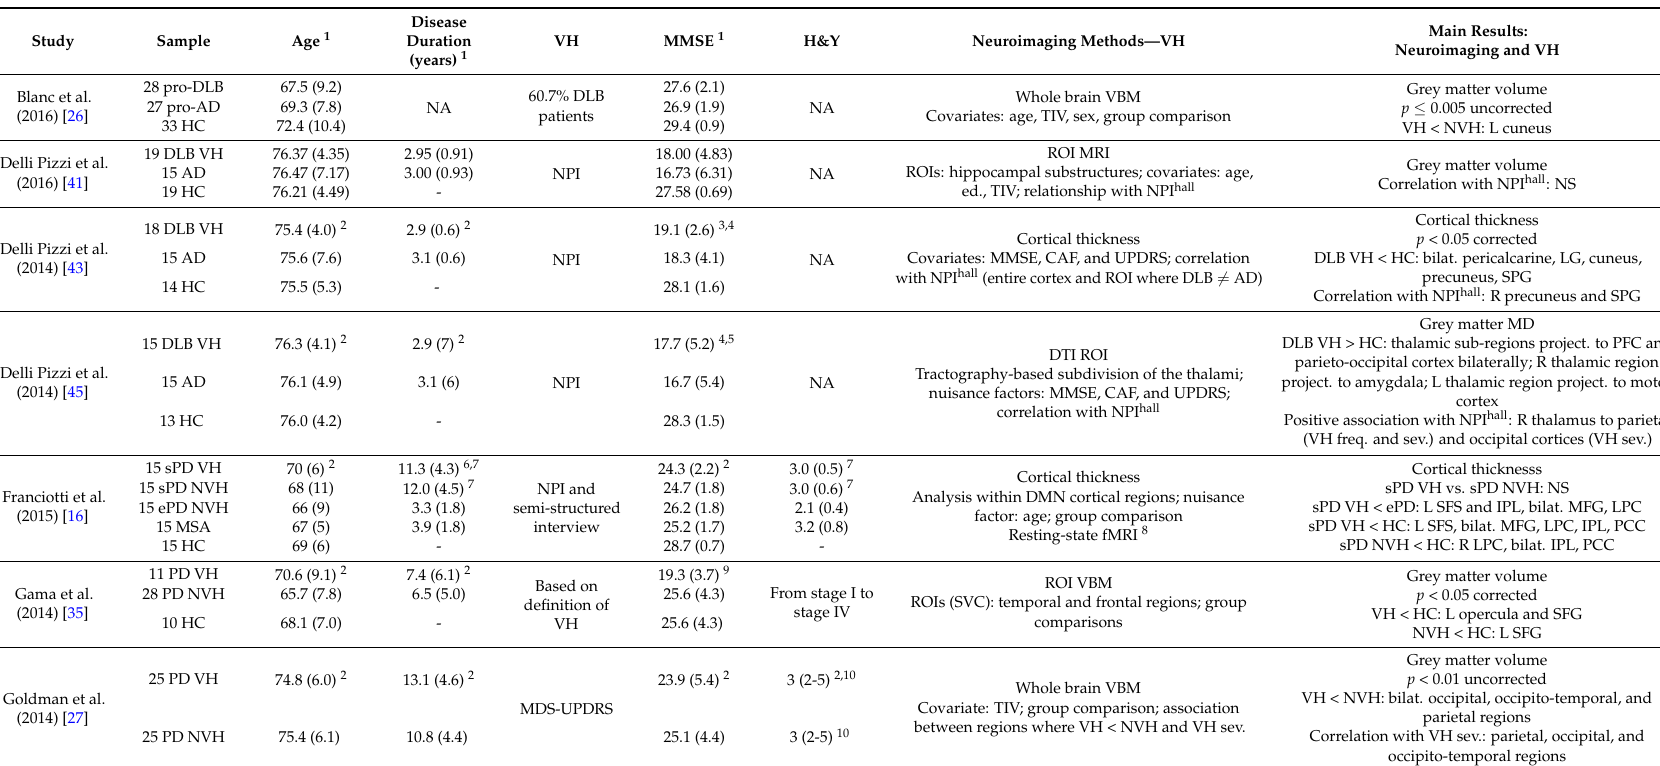
Table A1. Summary of structural neuroimaging studies of hallucinating patients with LBD. Only main results related to VH are reported.